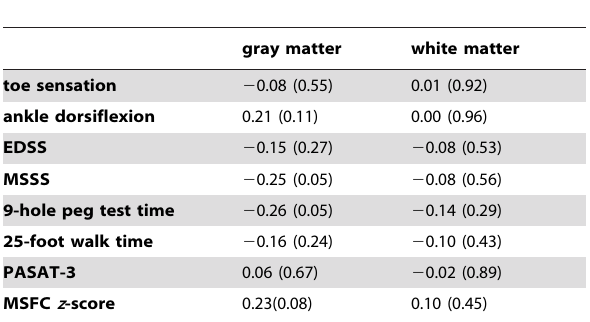
Table 5. Partial correlations of impairment measures with normalized structure volumes computed by FSL FAST segmentation